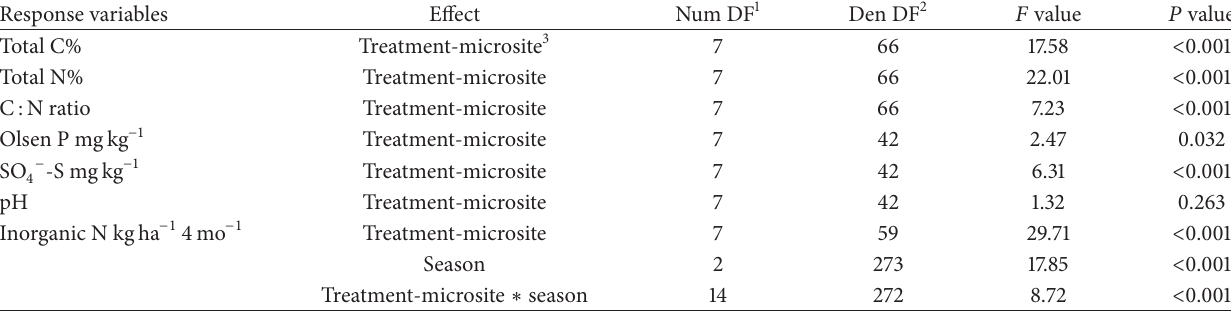
Table 2: Soil nutrient mixed-model analysis of variance and type III 𝐹 -tests from maximum likelihood estimation.